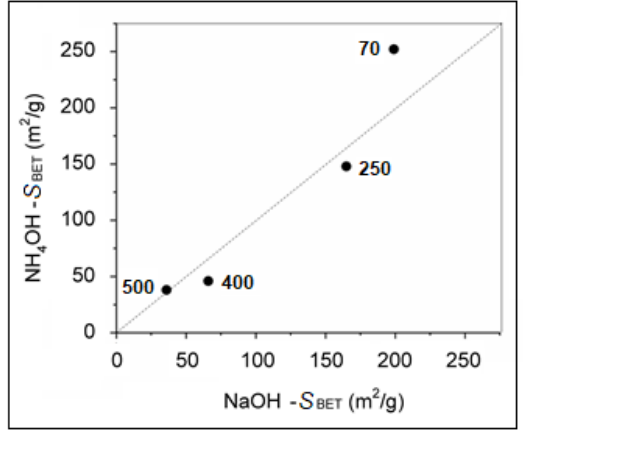
12 of 18 Figure 9. Measured nitrogen adsorption ‐ desorption isotherms and evaluated pore size distributions of Fe 2 O 3 nanoparticles prepared using the precipitators and calcined at different temperatures: NaOH ( a , b ) and NH 4 OH ( c , d ). The influence of the precipitation systems NaOH and NH 4 OH and calcination tem ‐ peratures on the specific surface areas and pore sizes is performed on the relations in Fig ‐ ure 10. Figure 10a reveals that procedure using NaOH precipitator produced hydrohema ‐ tite nanoparticles, showing generally higher specific surface areas at all the calcination temperatures used. Since Fe(III) ‐ based material prepared by NH 4 OH at 70 °C shows sig ‐ nificantly higher specific surface area of 252 m 2 /g in comparison with NaOH at 70 °C of 199 m 2 /g, more significant changes in the Fe 2 O 3 nanoparticles morphology prepared by NH 4 OH precipitation procedure can be expected at higher calcination temperature. Simi ‐